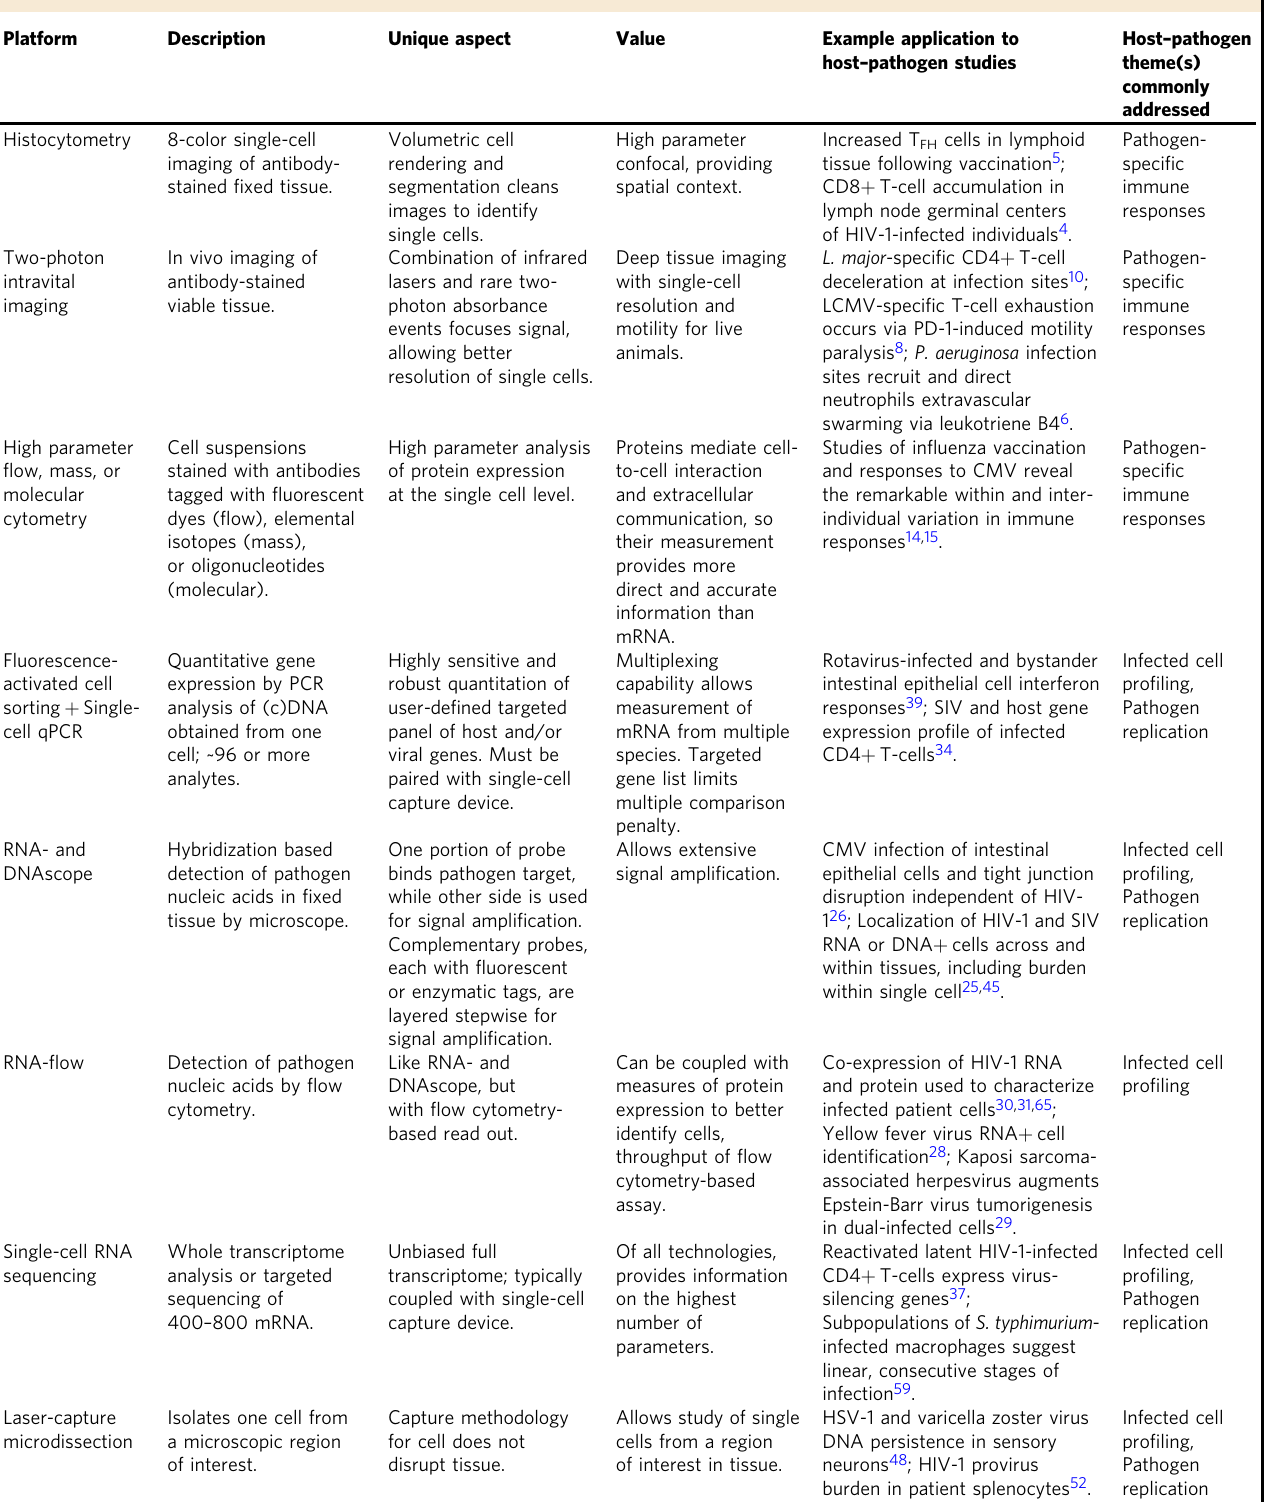
Table 1 Distinguishing features and underlying methods of single-cell technologies applied to the study of host – pathogen